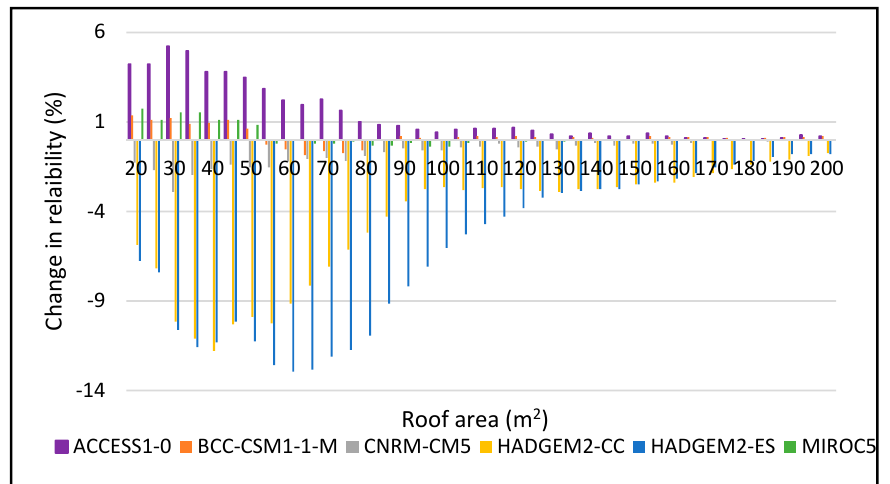
Figure 9. Change in reliability for DJF 2025–2055 period for 5 m 3 .